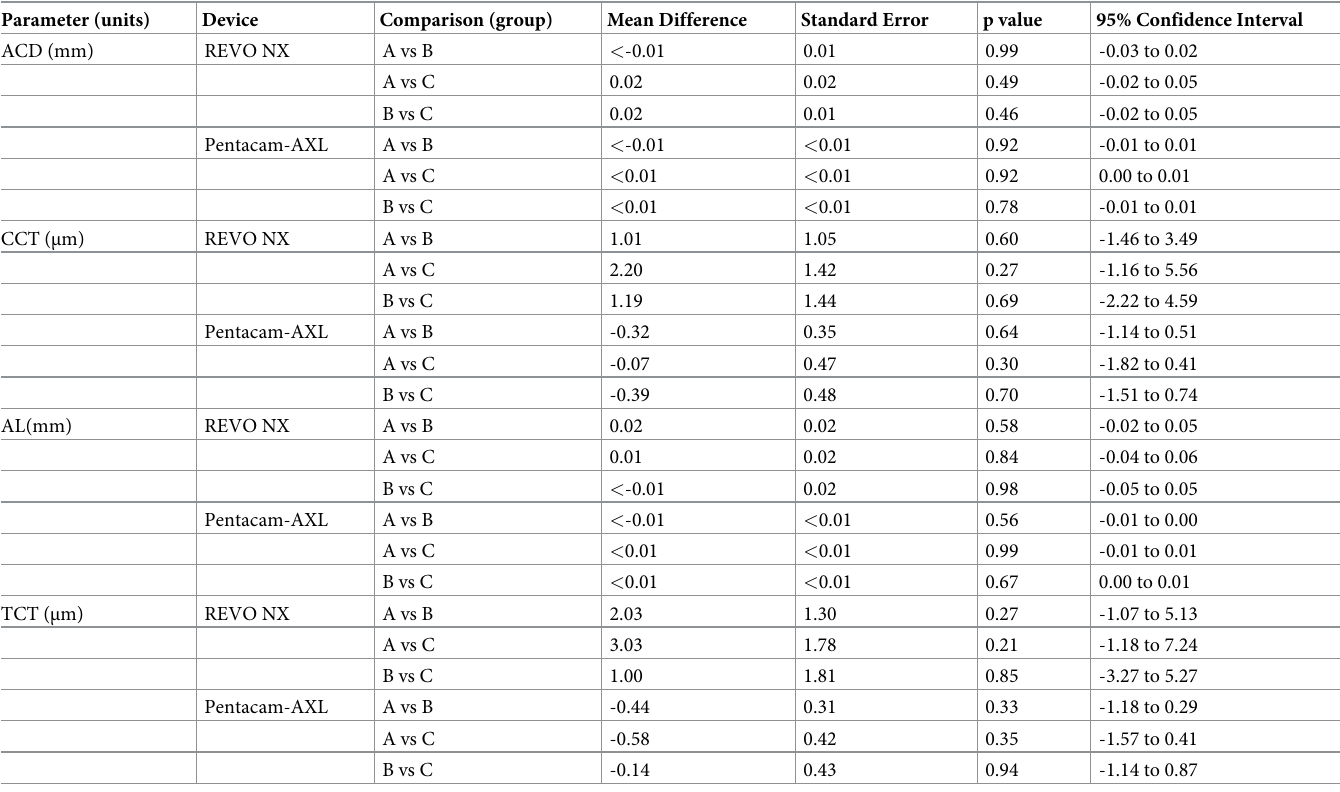
Table 4. Comparison of repeatability between groups. Parameter (units)